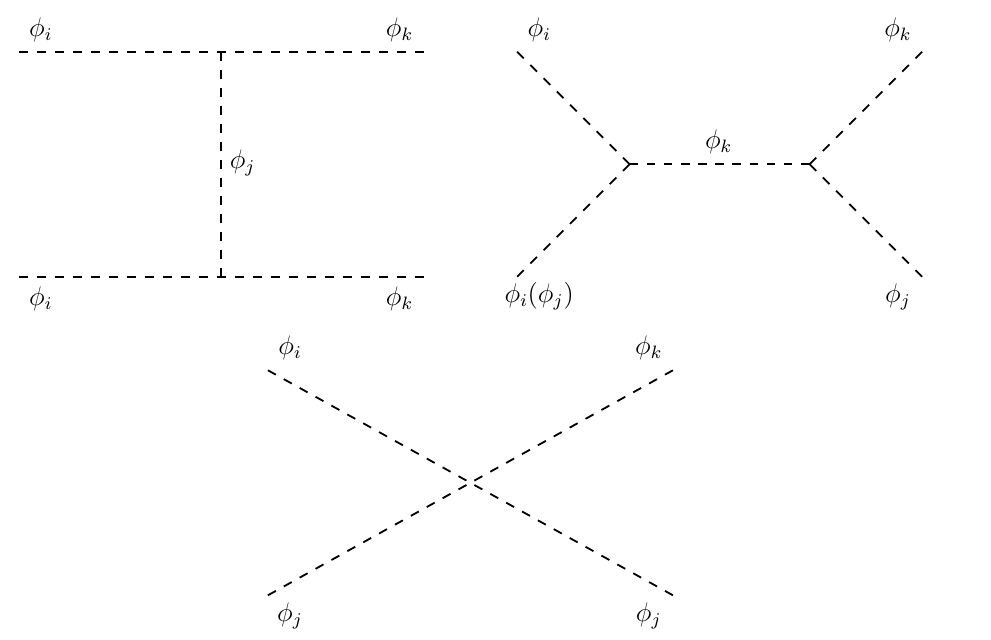
Figure 14 . DM conversion channels involving three DM